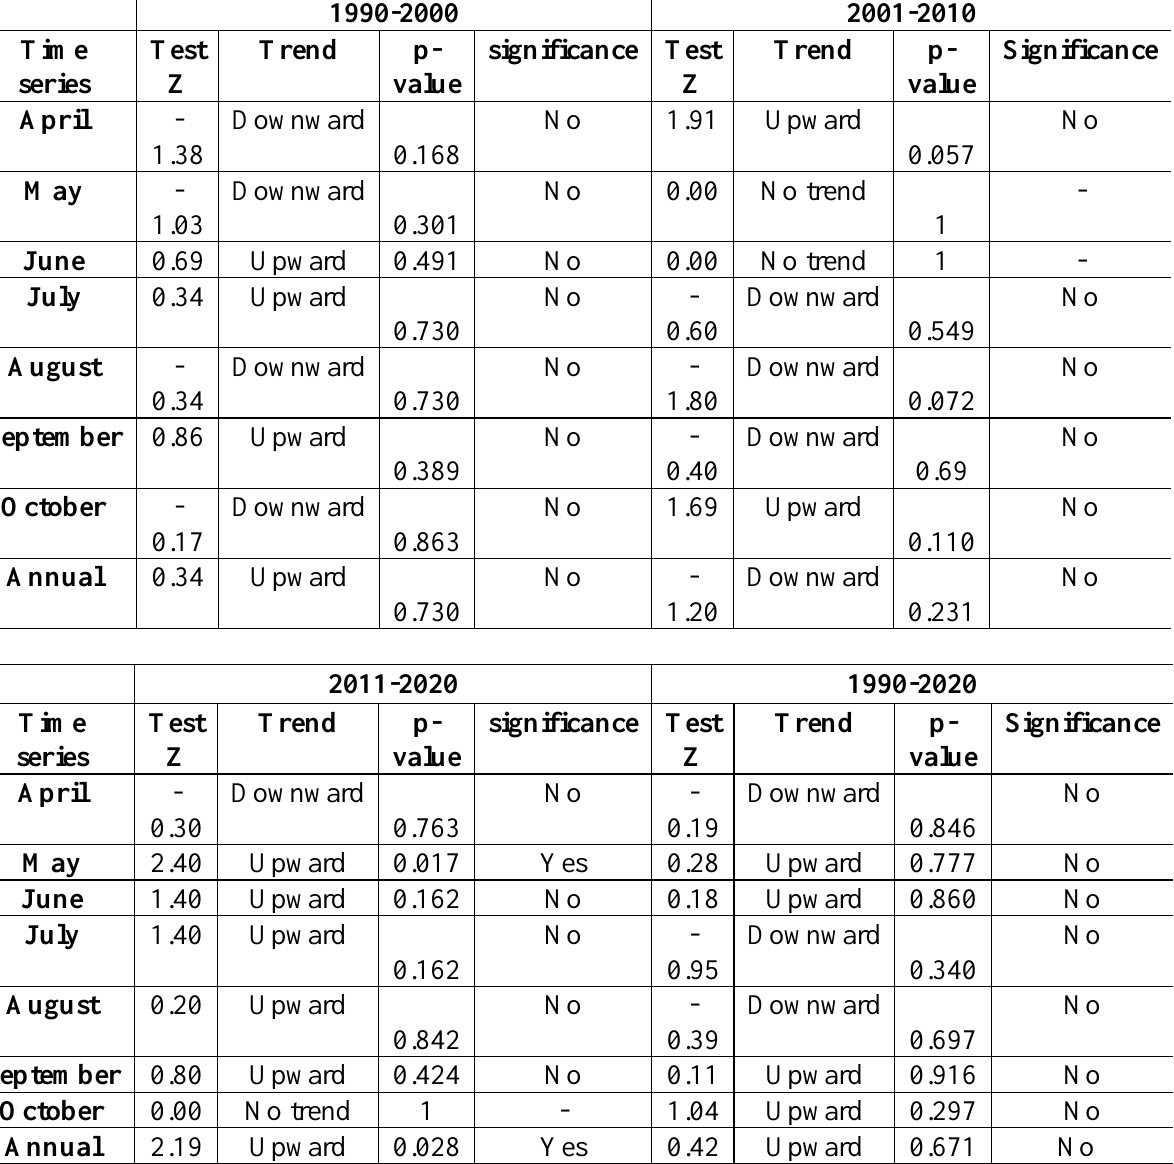
Table 4: Mann-Kendall Test results for monthly, annual and decadal Rainfall in Gombe